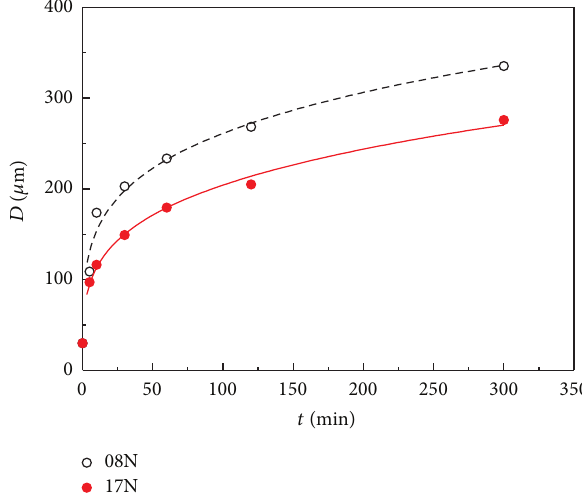
Figure 10: Distributions of misorientation angle in the matrix after holding at 1473 K for 60 min.